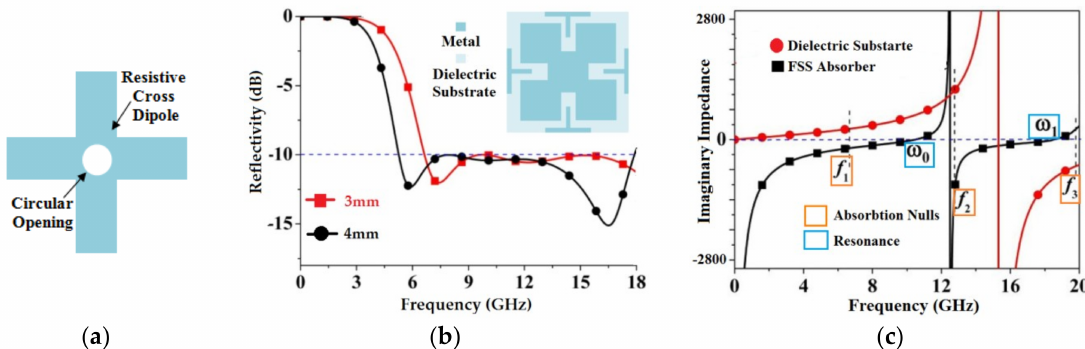
Figure 15. ( a ) Novel transmit/absorb FSS element ( b ) Broadband lossy FSS absorber in the inset and optimized reflectivity graph for 3 mm and 4 mm thickness ( c ) Impedances of 4mm grounded substrate and proposed FSS highlighting the resonances and absorption